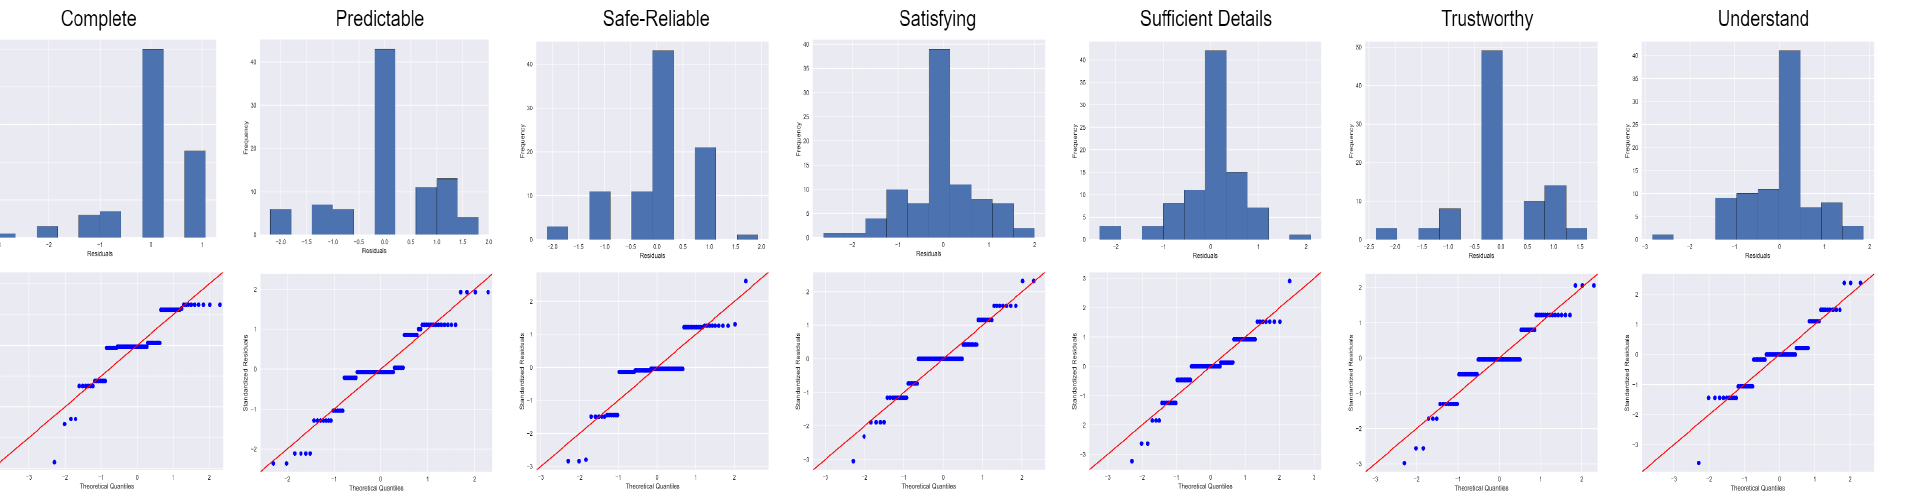
Figure A3. Histograms of the distribution of the residuals and Q-Q plots for each quality of the “Why not”